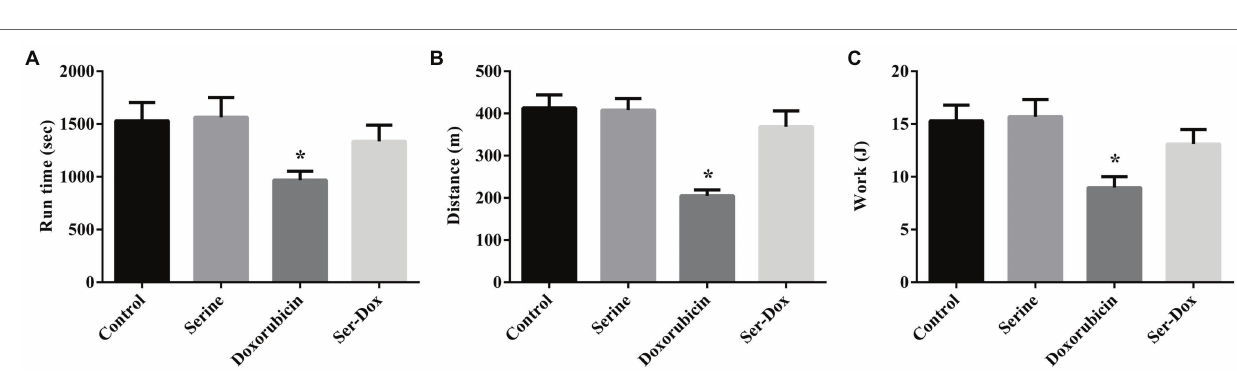
FIGURE 5 | Effects of serine administration on the exercise capacity of mice. (A) Run time, (B) distance, and (C) excise performance were evaluated. Values are expressed as LSmean plus pooled SEM, n = 8. *Mean values were significantly different among groups ( p <